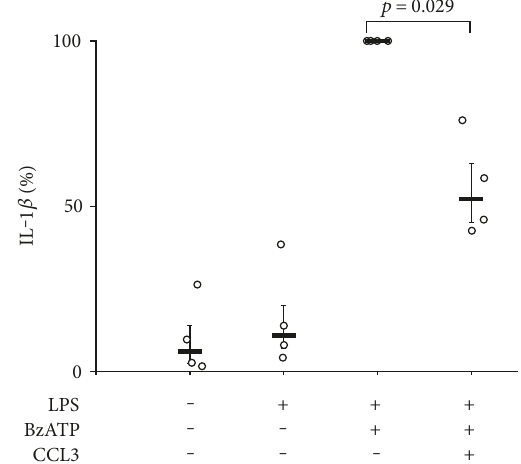
Figure 2: CCL3 inhibits ATP-induced IL-1 β release by human peripheral blood mononuclear cells (PBMC). Blood from healthy volunteers was pulsed with 0.5ng LPS/ml before puri fi cation of PBMC. PBMC were cultured for 3h, and 2 ′ (3 ′ )-O-(4- benzoylbenzoyl)adenosine-5 ′ -triphosphate (BzATP; 100 μ M) was added for 30 min in the presence or absence of CCL3 (10 ng/ml). IL-1 β was measured in cell culture supernatants, and the values obtained in the supernatants of cells treated with LPS and BzATP were set to 100%. Data are presented as individual data points, bars indicate median, and whiskers percentiles are 25 and 75; n = 4